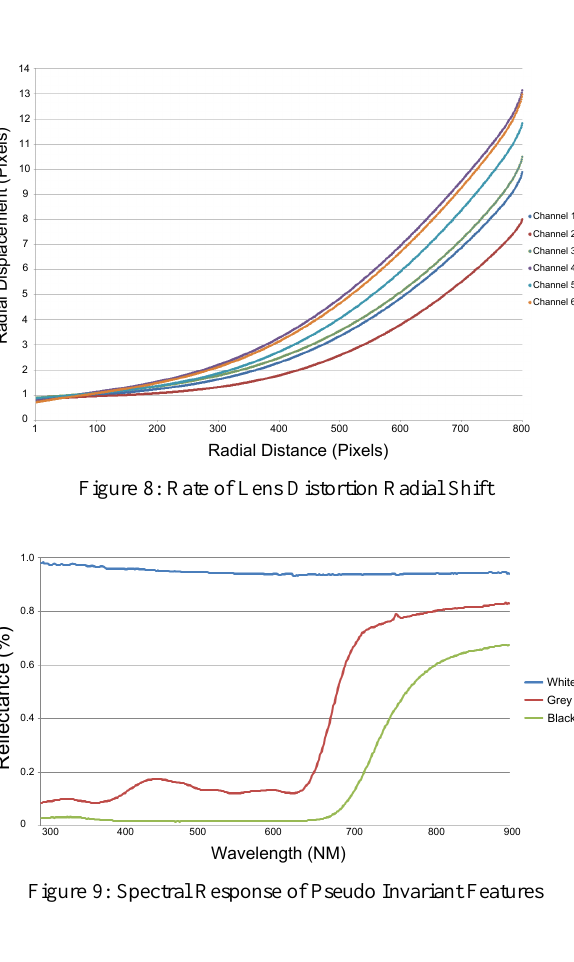
Figure 9: Spectral Response of Pseudo Invariant Features